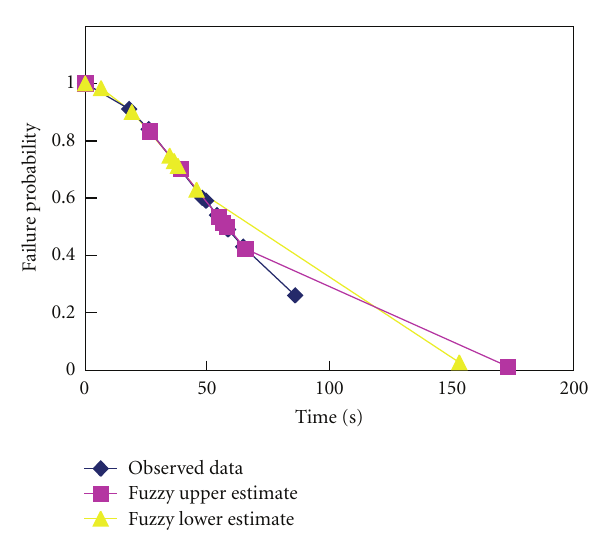
Figure 4: Failure probability curves.